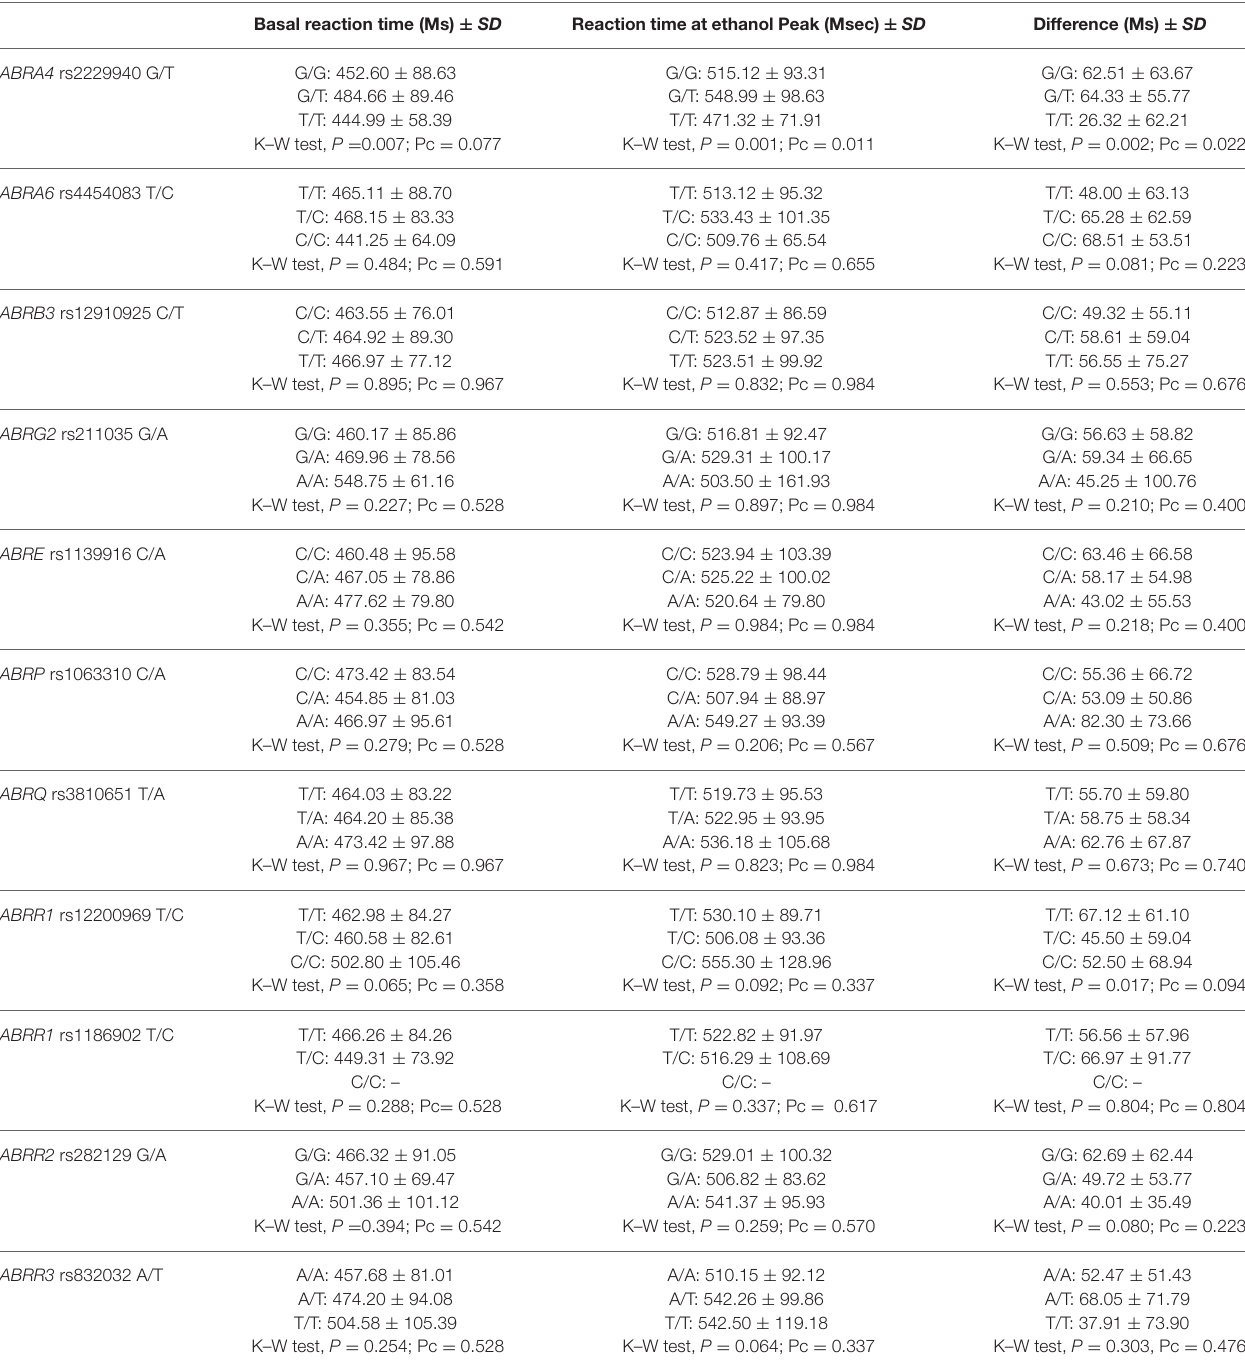
TABLE 3 | Distribution of reaction times according GABR genotypes. Basal reaction time (Ms) ±